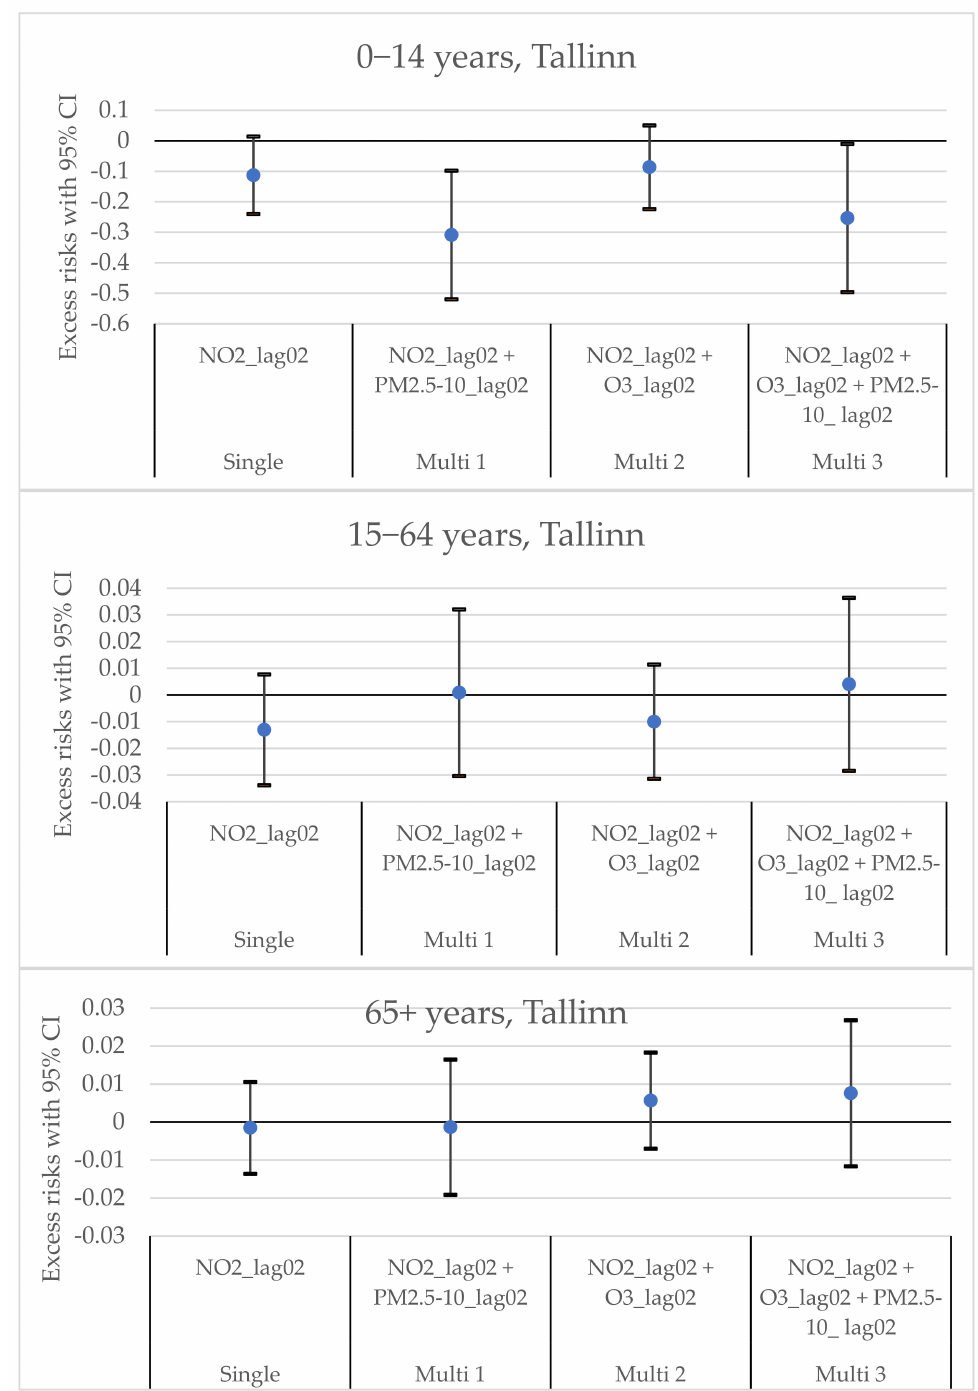
Figure 8. Multi-pollutant models of the estimated change in daily mortality in different age groups (with 95% CI) for an IQR increase in the concentration of NO 2 (lag02) in Tallinn. From left to right: a single-pollutant estimate of NO 2 (Single), NO 2 adjusted for PM 2.5–10 (Multi 1), NO 2 adjusted for O 3 (Multi 2), and NO 2 adjusted for both O 3 and PM 2.5–10 (Multi